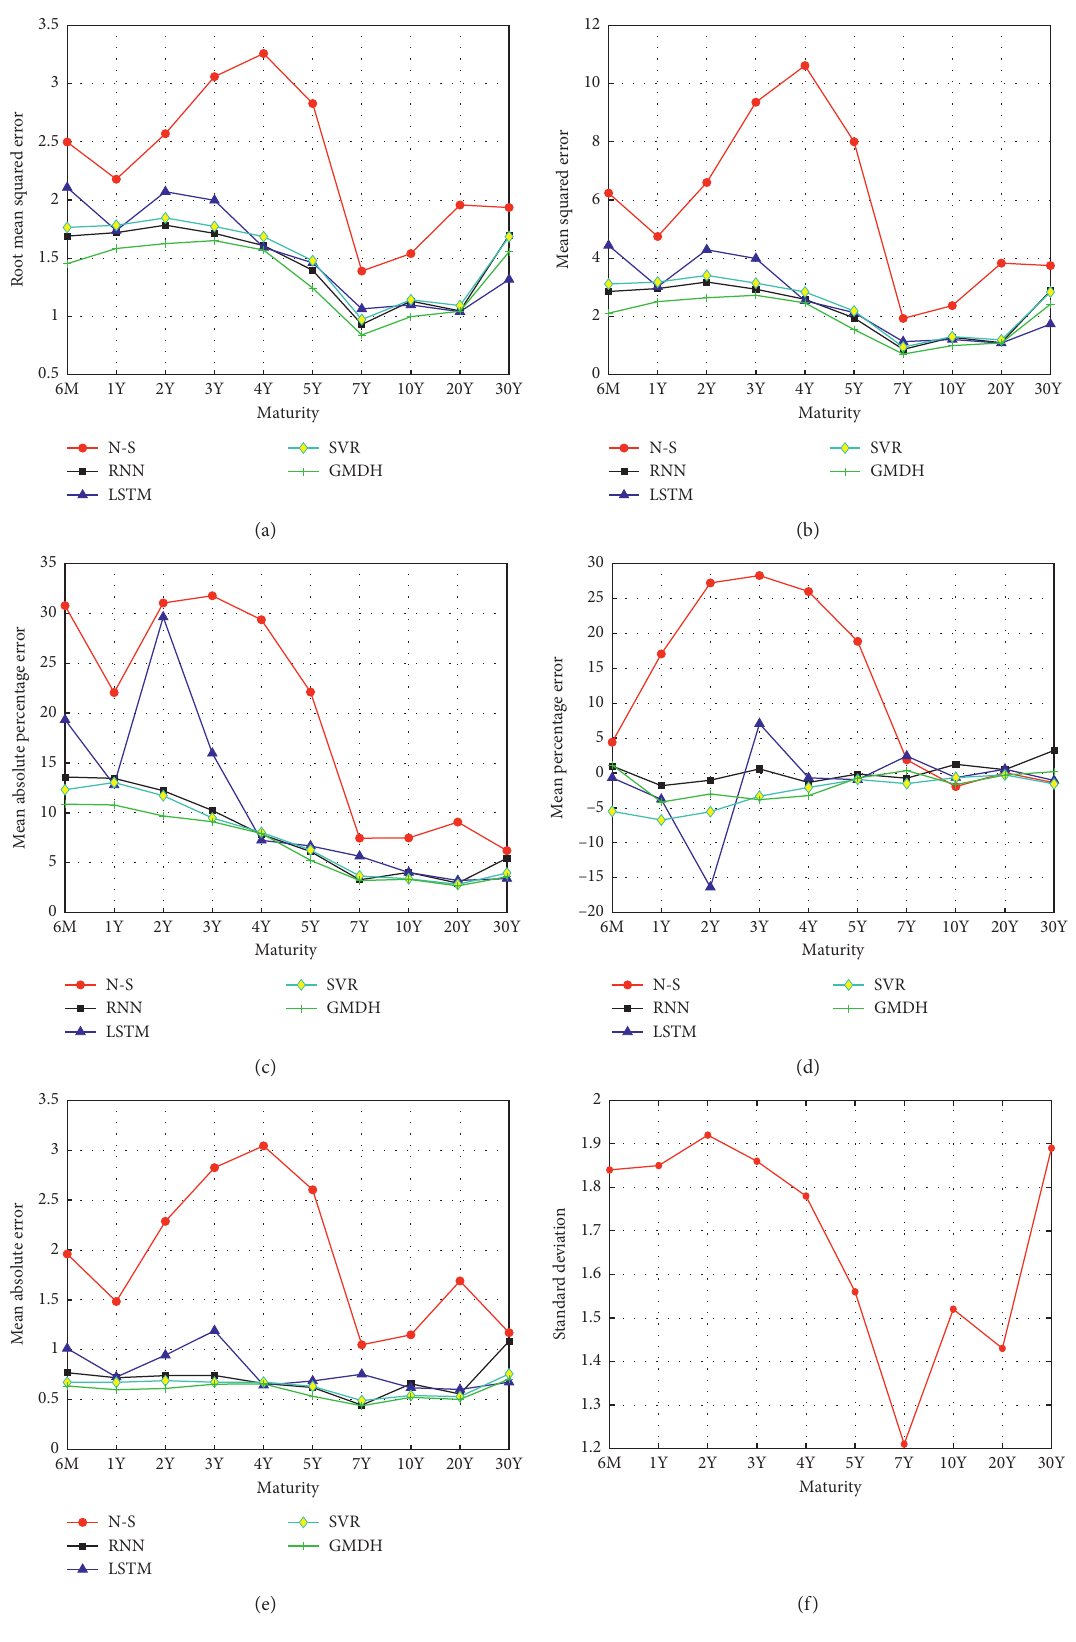
Figure 14: Error of each method for all maturities from Table 8 and standard deviations for all maturities (case 3): (a) RMSE (subperiod 2 training set); (b) MSE (subperiod 2 training set); (c) MAPE (subperiod 2 training set); (d) MPE (subperiod 2 training set); (e) MAE (subperiod 2 training set); (f) test dataset